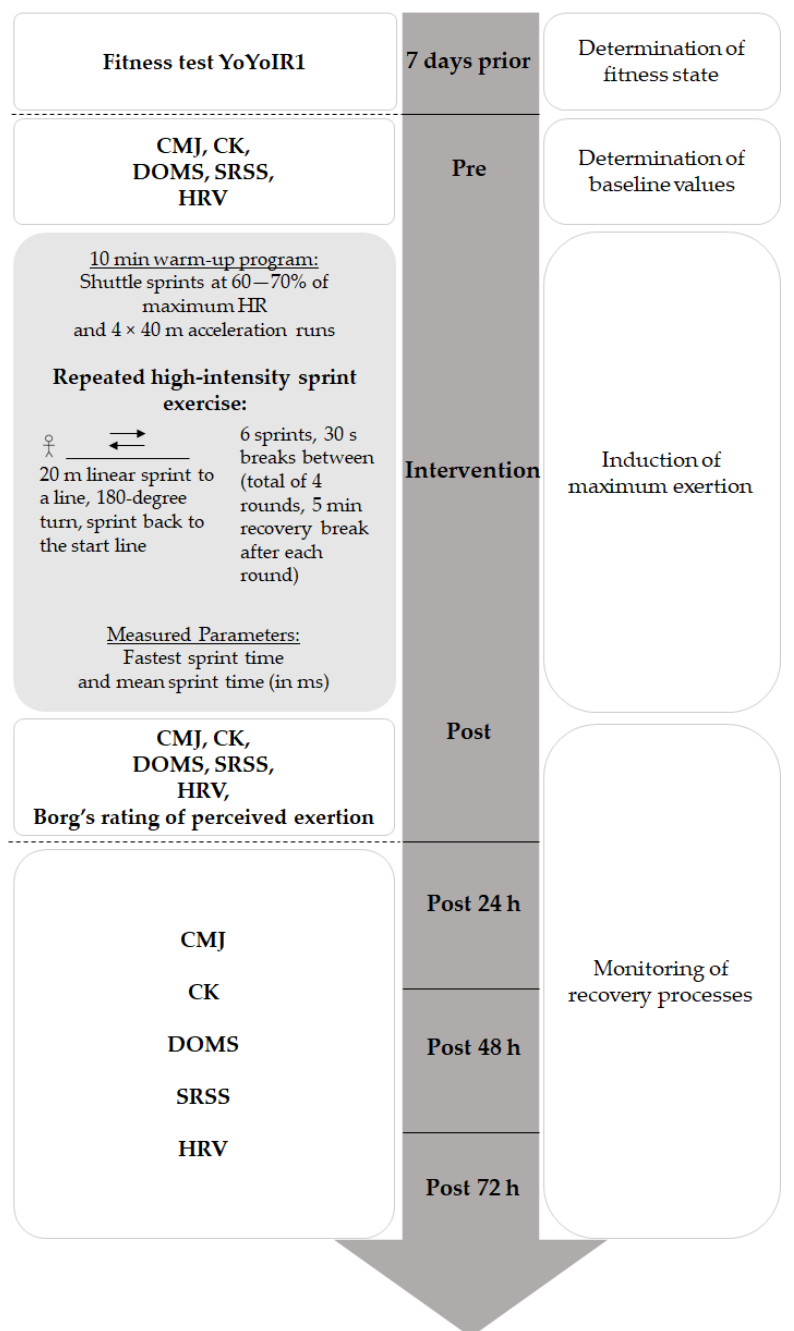
Figure 1. A flow chart demonstrating the process of the cross-section-measurement (YoYoIR1 = YoYo Intermittent Fitness Test, CMJ = counter movement jump, CK = creatine kinase, DOMS = delayed onset of muscle soreness, SRSS = short recovery and stress scale for sport, HRV = heart rate variability).